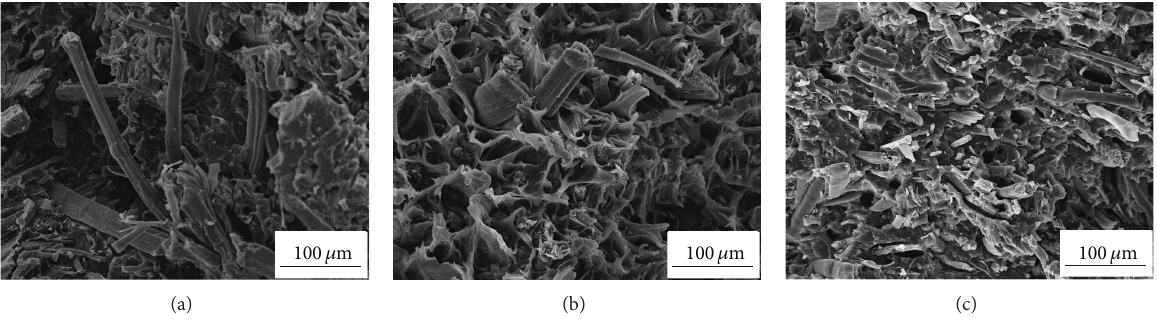
Figure 4: SEM images of fracture surface of (a) NHF/PP; (b) NHF/PP/MAPP; (c) HMHEC/NHF/PP/MAPP.